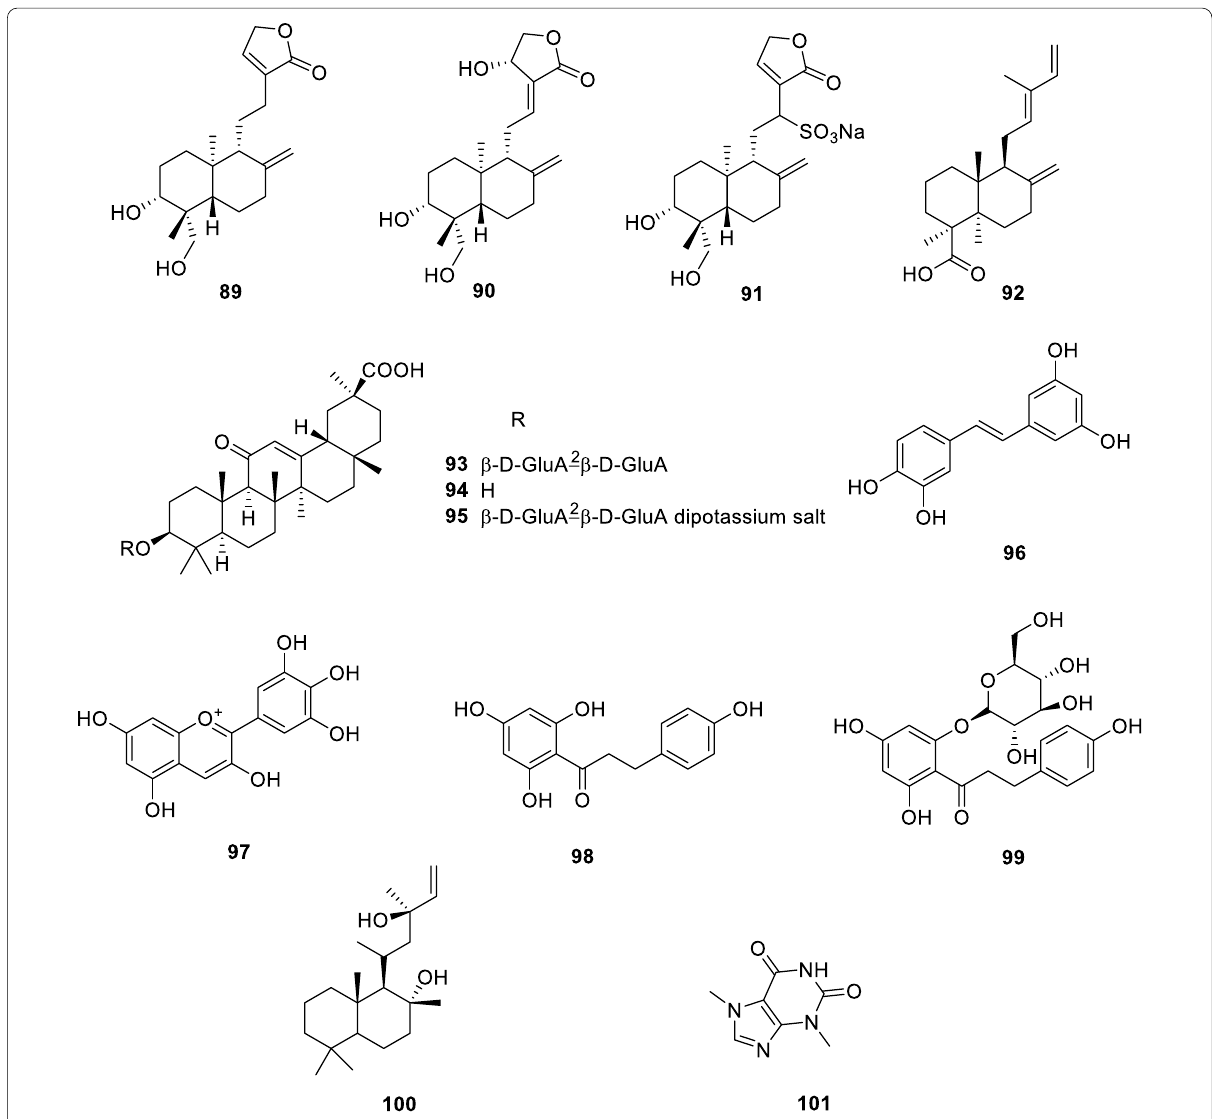
Fig. 13 Structures of natural products as anti‑aging